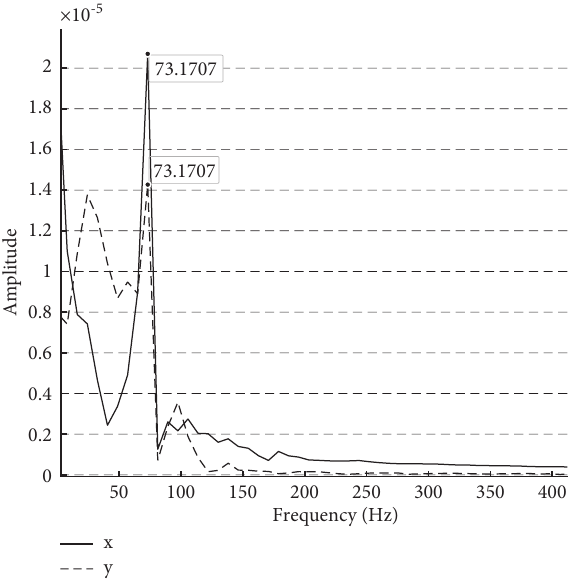
Figure 25: X- and Y -axis vibration displacement frequency-domain curves.